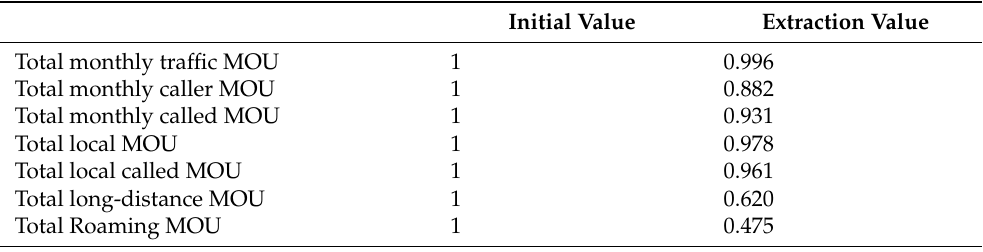
Table 10. Common factor